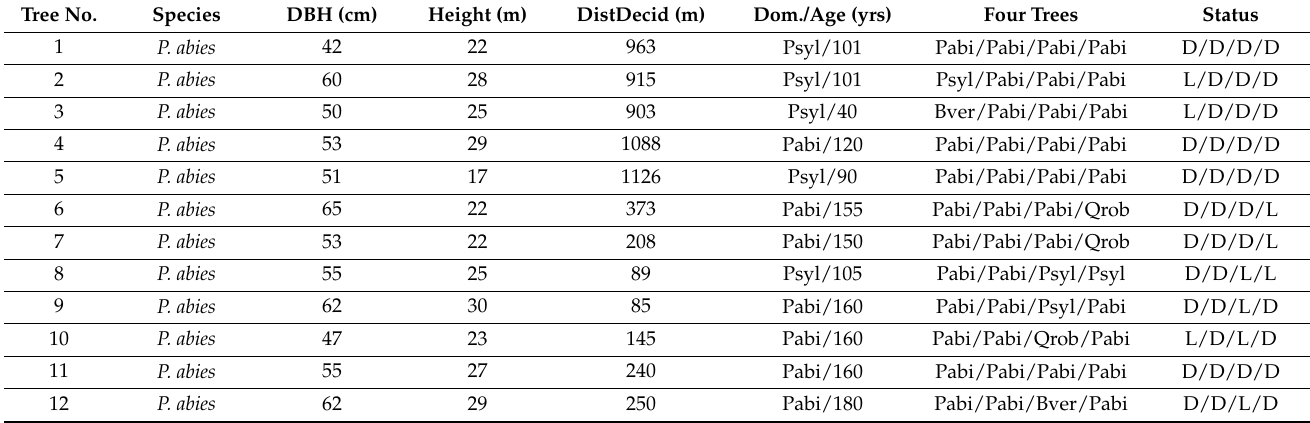
Figure 3. Study area. Bat netting sites (four) marked with asterisks. Spruce roosting trees marked with yellow circles. Alder roosting tree marked with diamond. The ovals with a dotted line surround the respective netting points (1–4) along with the roosts used by the bats captured at these points. They are drawn for reference only. Table 2. The main parameters of the trees in which the bat roosts were found. Tree